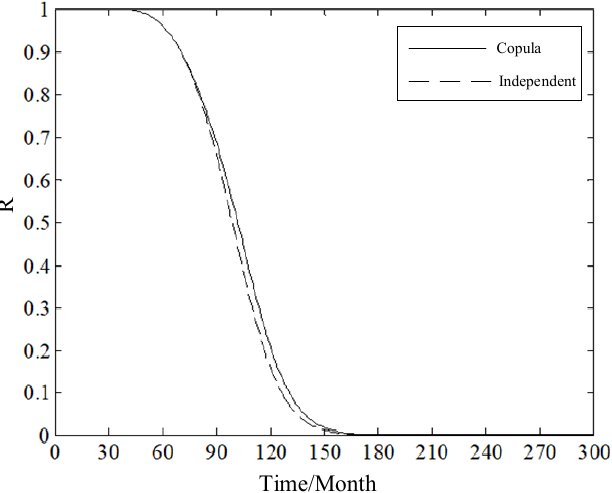
Figure 4. Comparison between Couple-based reliability function and independent reliability function.